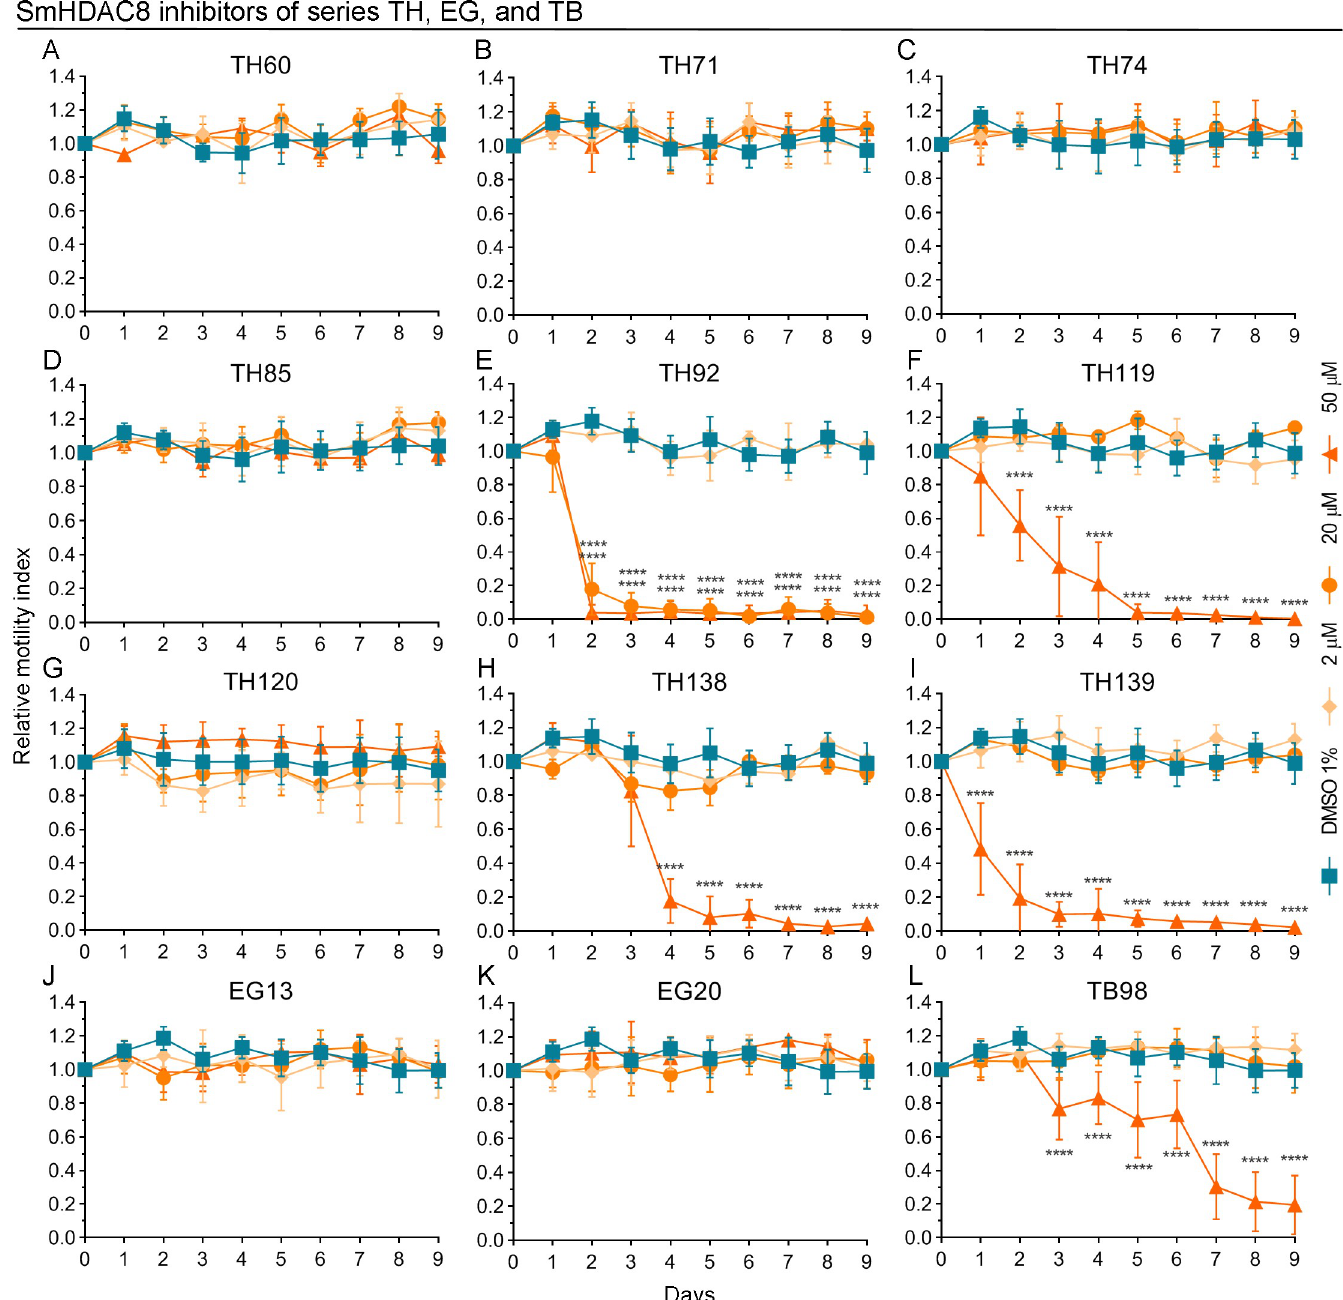
Fig 2. Effect of SmHDAC8 inhibitors (series TH, EG, and TB) on Mesocestoides vogae viability. In vitro anthelmintic activity was determined for compounds of the series TH: (A) TH60, (B) TH71, (C) TH74, (D) TH85, (E) TH92, (F) TH119, (G) TH120, (H) TH138, and (I) TH139; series EG: (J) EG13 and (K) EG20; and series TB: (L) TB98. All compounds were evaluated at concentrations of 2, 20, and 50 μ M and at different incubation times using the M . vogae TTy motility assay. Parasites incubated with the drug vehicle (1% DMSO) were used as a negative control. Relative motility indices were measured from three independent biological replicates, each one in quadruplicate. Error bars represent the standard deviation and the asterisks indicate those values that showed differences with statistical significance compared to the negative control, according to two-way ANOVA test and Dunnett’s post-tests ( � , p < 0.05; �� , p < 0.01; ��� , p < 0.001; ���� , p < 0.0001).